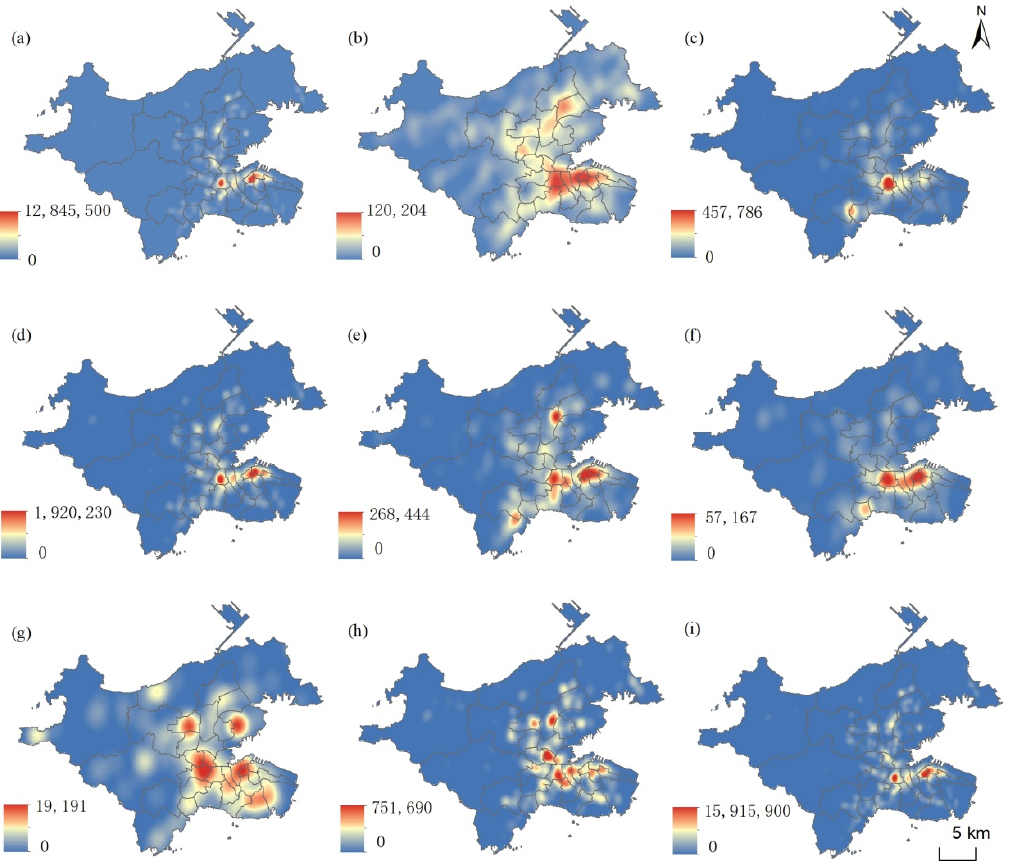
Figure 2. Spatial distribution of public service facilities: ( a ) Represents shopping/catering; ( b ) represents transportation facilities; ( c ) represents educational facility; ( d ) represents life services; ( e ) represents physical fitness; ( f ) represents cultural/leisure facilities; ( g ) represents elderly care facilities; ( h ) represents medical facilities; ( i ) represents total facilities.